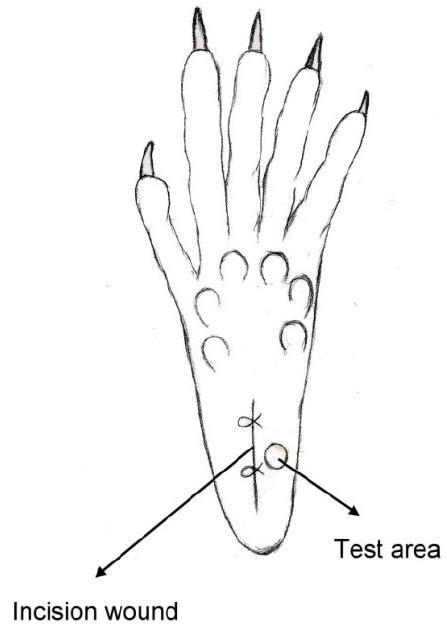
Figure 4. Schematic of the paw